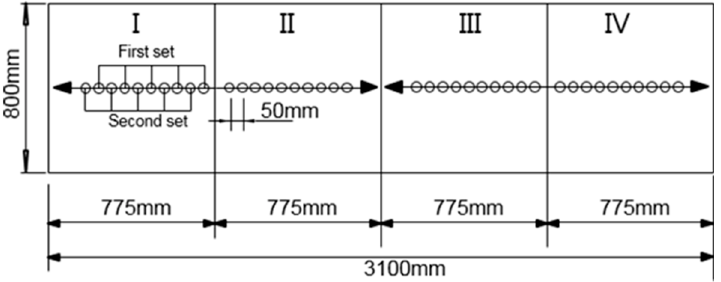
Figure 6. A planar view of the four test paths for the MASW test. The O marks indicate the sensor positions in each path, and the arrows show the direction of each test.